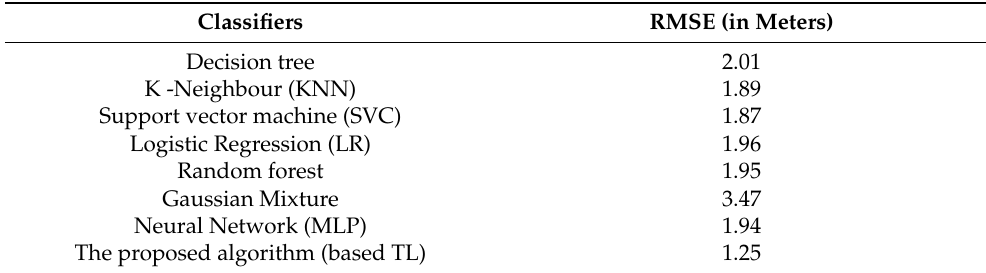
Table 9. Models’ target prediction using the original feature spaces of 9 Wi-Fi access points based on